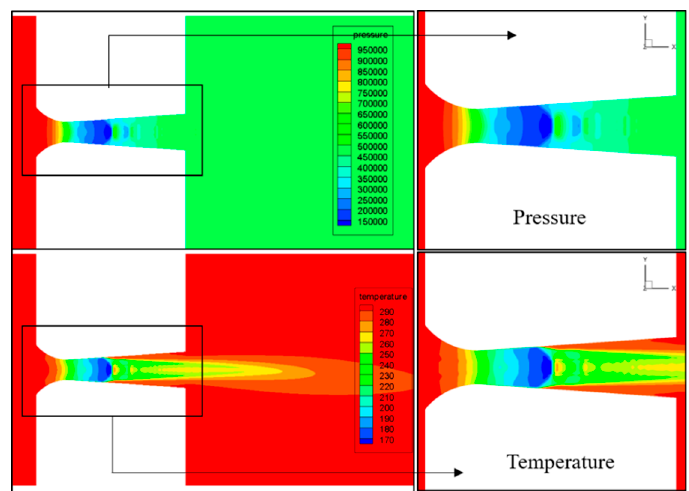
Figure 9. Entire computational domain, numerical meshes, and boundary conditions.